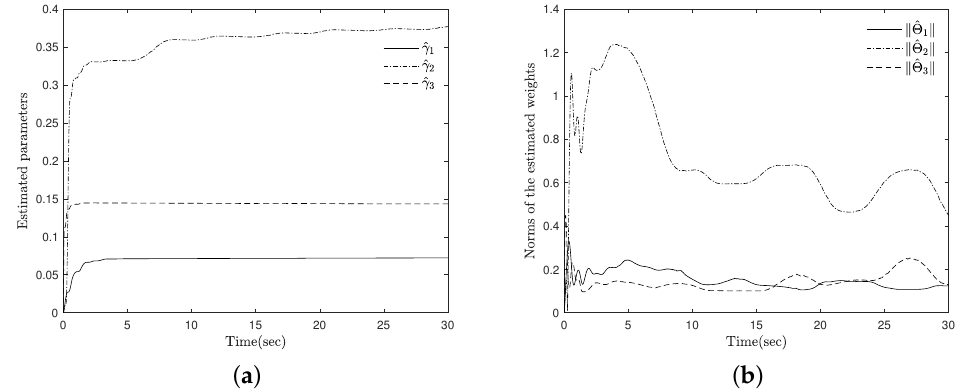
Figure 5. Estimation results of the proposed control system for Example 2: ( a ) ˆ γ j , j = 1,2,3; and ( b ) (cid:107) ˆ Θ j (cid:107) , j = 1,2,3.